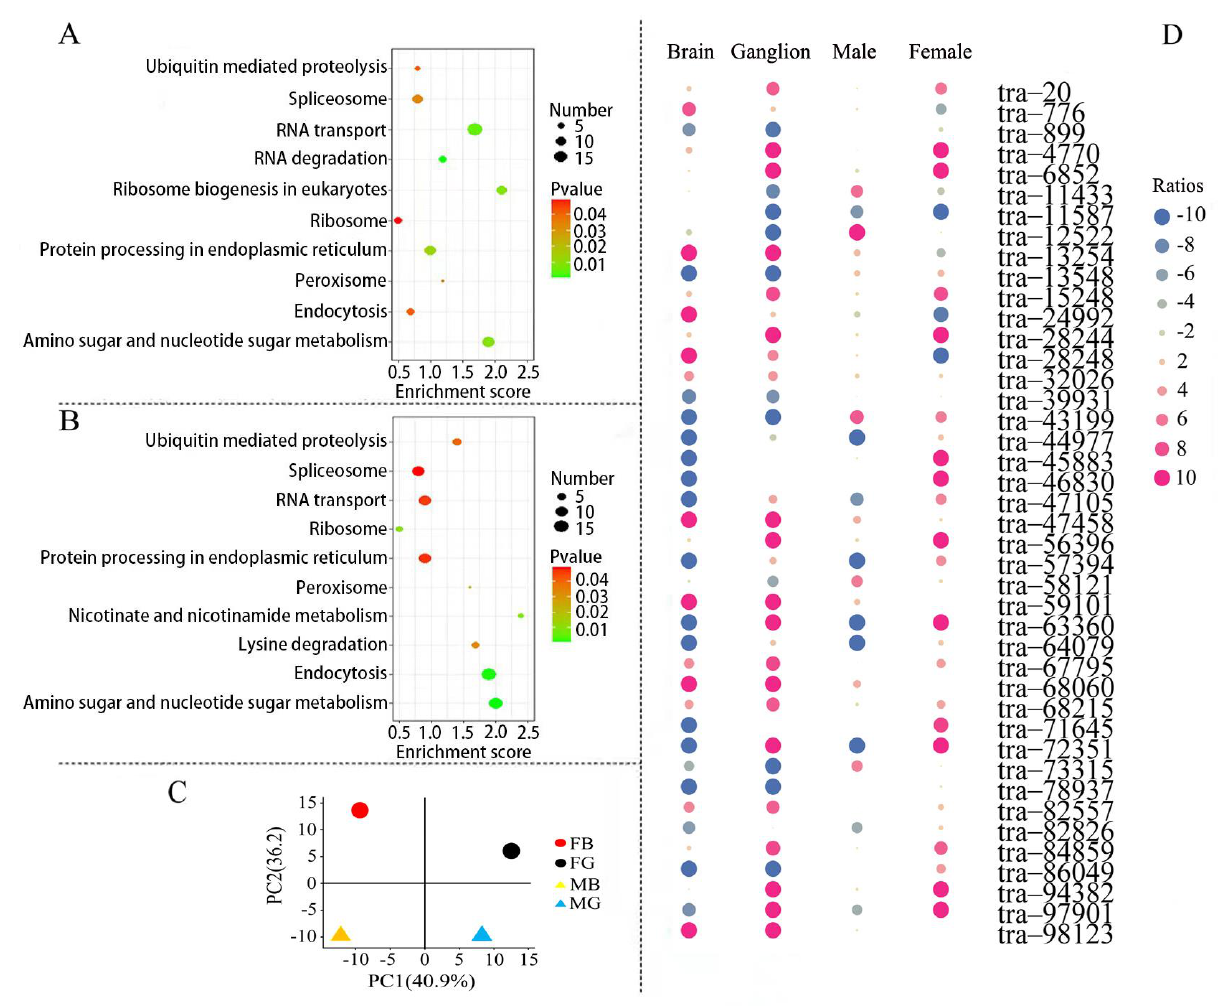
Figure 7. Annotation and distribution of DEGs (|log2FC| > 2, p -value < 0.05) in the protein processing pathway in the endoplasmic reticulum of M. rosenbergii . KEGG enrichment of DEGs in up-regulated expression in the brain ( A ) and up-regulated expression in the thoracic ganglion ( B ). The DEGs were separated into different principal components ( C ). The distribution is shown in ( D ) according to the tissues and sexes of M. rosenbergii . FB: female brain; FG: female thoracic ganglion; MB: male brain; MG: male thoracic ganglion; brain and ganglion denoted differentially expressed genes in male brain and ganglion with female as a control; male and female denoted differentially expressed genes in the male and female brain with ganglion as a control; Ratios denoted the ratio of gene expression amount in the genders and tissues, and a negative/positive number indicated down-/up-regulated expression.